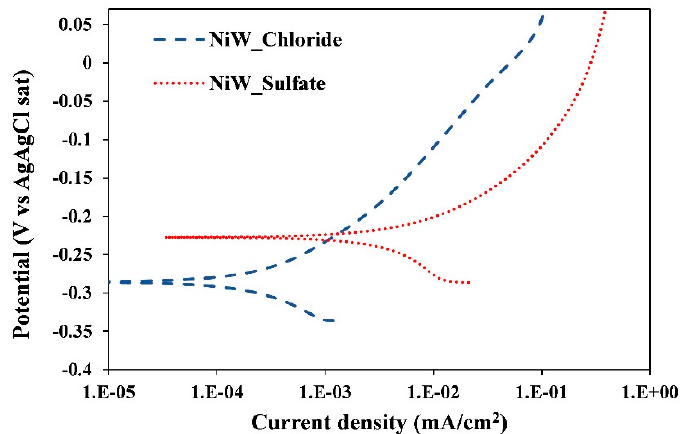
Figure 3. Potentiodynamic polarization curves of NiW coatings in neutral 3.5 wt% NaCl solution (areas on X-axis are visible and not real). Table 1. Corrosion parameters for NiW coatings (areas are visible and not real).